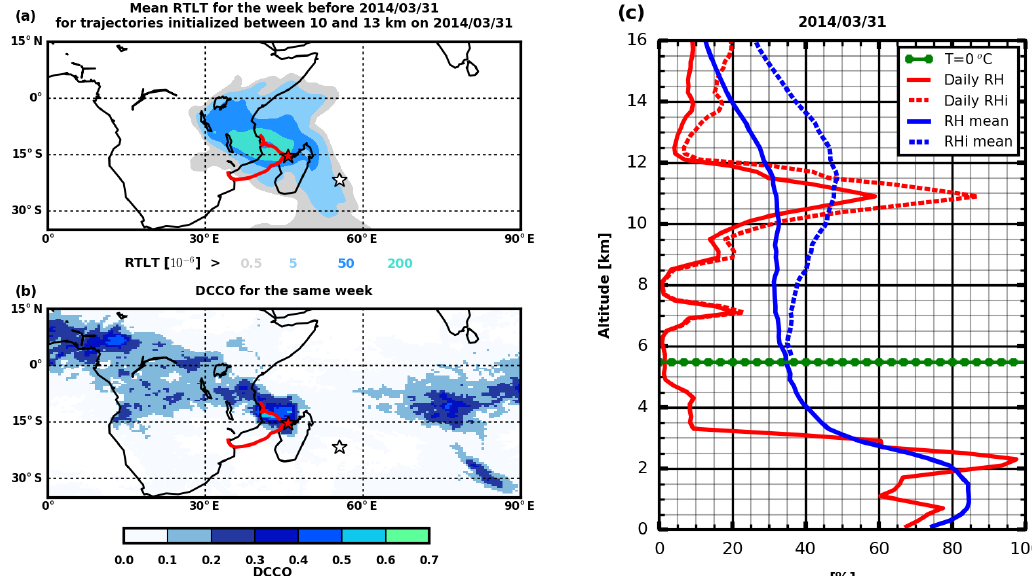
Figure 8. (a) Fraction of residence time below 5km (RTLT) for air masses initialized in the upper troposphere (10–13km) over Réunion island on 31 March 2014. (b) Map of DCCO for the week before 31 March 2014. In panels (a) and (b) the best-track data are provided by Météo-France. In the two panels on the left, the red star indicates the position of Tropical Cyclone Hellen on 31 March 2014, and the white star corresponds to the location of Réunion island. (c) RH / RHi profiles on 31 March 2014 (solid and dotted red lines, respectively) and seasonal mean RH / RHi profiles (solid and dotted blue lines, respectively) over austral summers 2014, 2015 and 2016. The dotted green line corresponds to the 0 ◦ C isotherm.